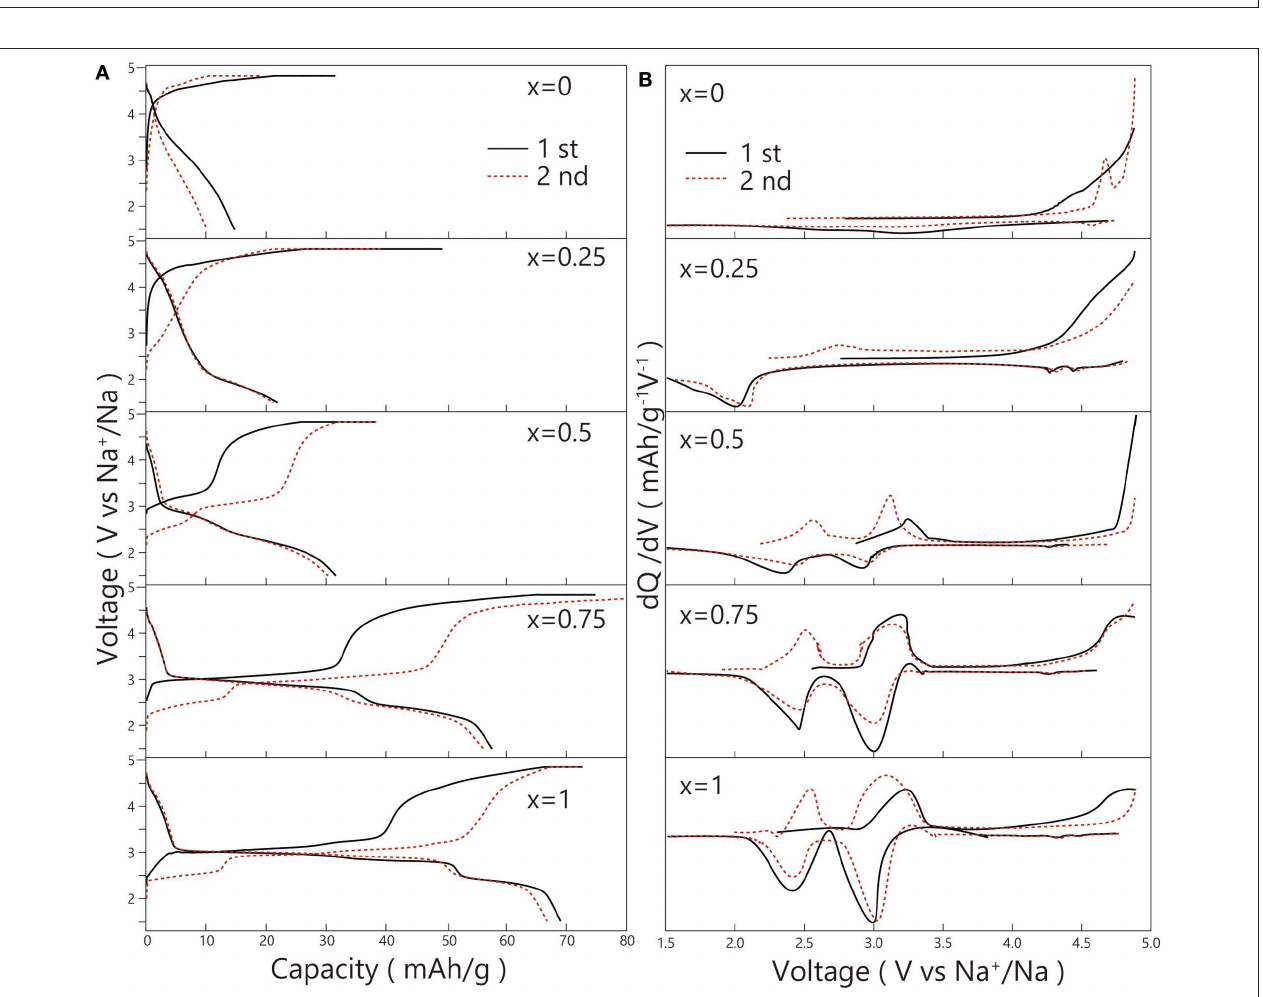
FIGURE 10 | (A) 1st and 2nd charge-discharge curves; (B) dQ/dV plots at 1st and 2nd cycles of the Na 2 Fe x Ni 1 − x P 2 O 7 glass-ceramics.